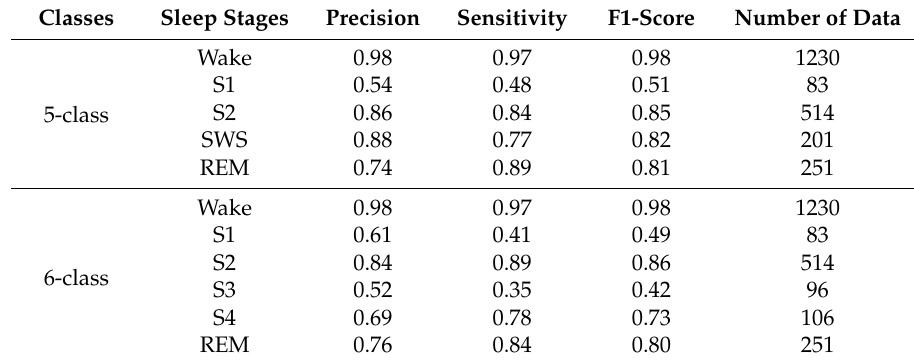
Table 5. Various performance values obtained for five-class and six-class test data using a sleep-edf database with single-channel EOG.